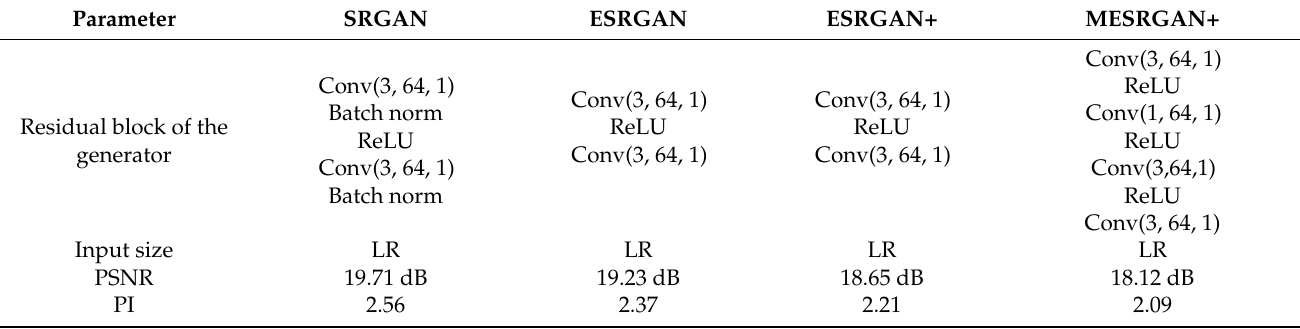
Figure 4. Comparison results of our proposed MESRGAN+ and other selected SOTA models with the same dataset. The PI value is reported on the left and the PSNR is reported on the right. Table 2. Comparison of the structural configuration of SRGAN, ESRGAN, ESRGAN+ and our proposed MESRGAN+, including their reported peak signal to noise ratio (PSNR) and PI value, using the same CXR